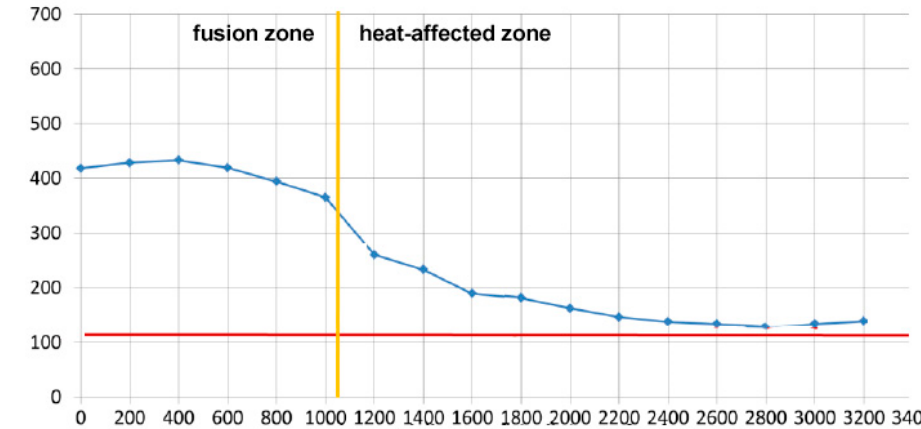
Figure 9. Example of the trend of Vickers micro-hardness under condition F; flat deposition. Table 7. Average Vickers micro-hardness as a function of the processing conditions; flat deposition.